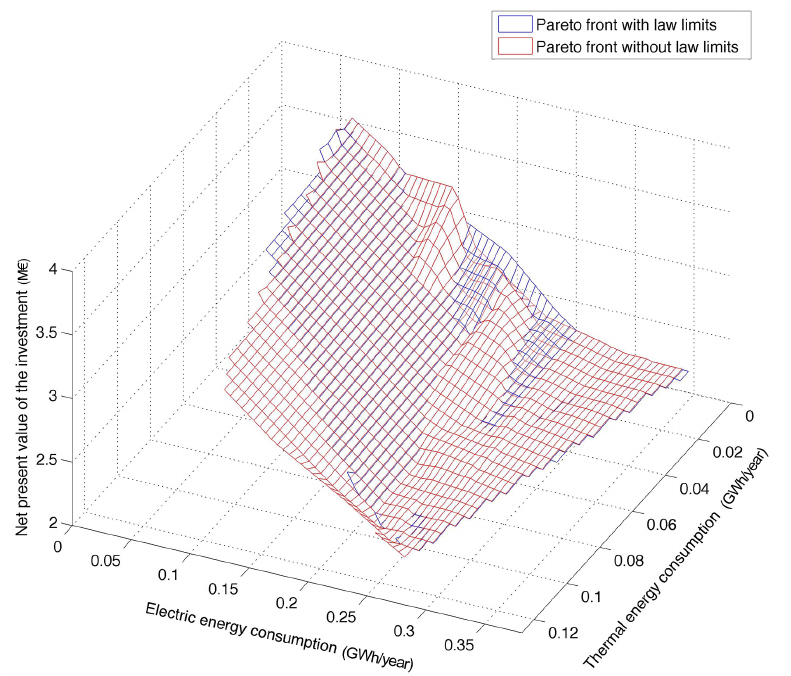
Figure 3. Effects of legal limits on the generation of the Pareto front for the case study building.